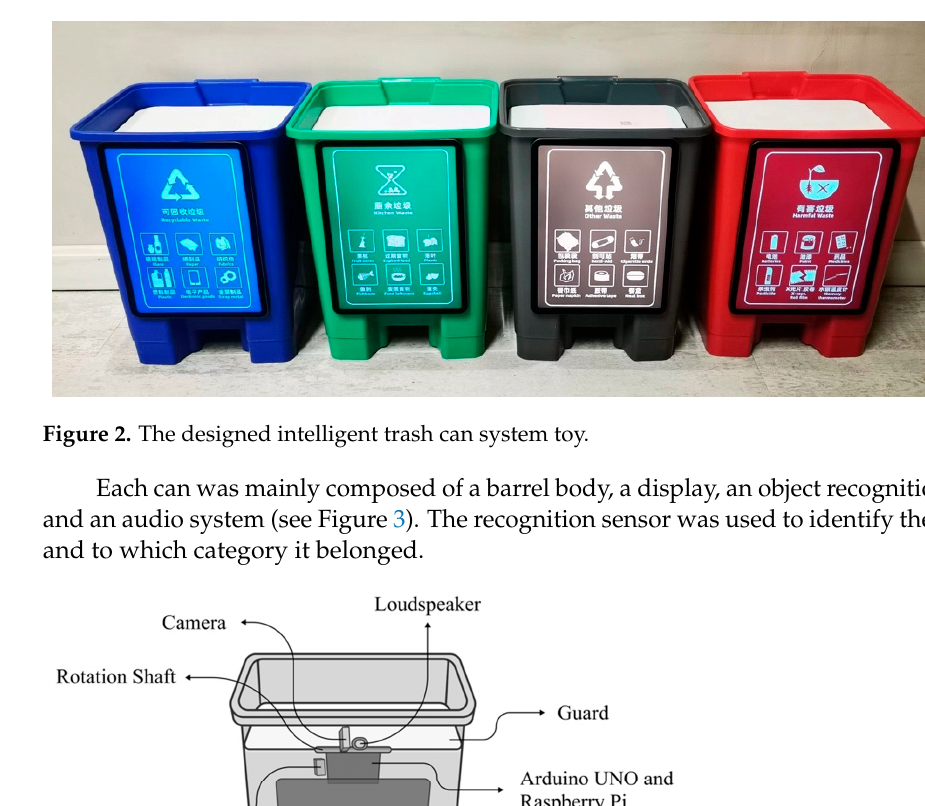
( b ) Figure 4. Expressive reactions of the designed intelligent trash can system toy. The toy displayed different expressions to distinguish whether users threw the garbage into the wrong trash can or not ( a ). The garbage thrown in the trash was displayed in the form of cute cartoons on the monitor ( b ). An animated story showed how the garbage was treated and recycled into new items (Figure 5).